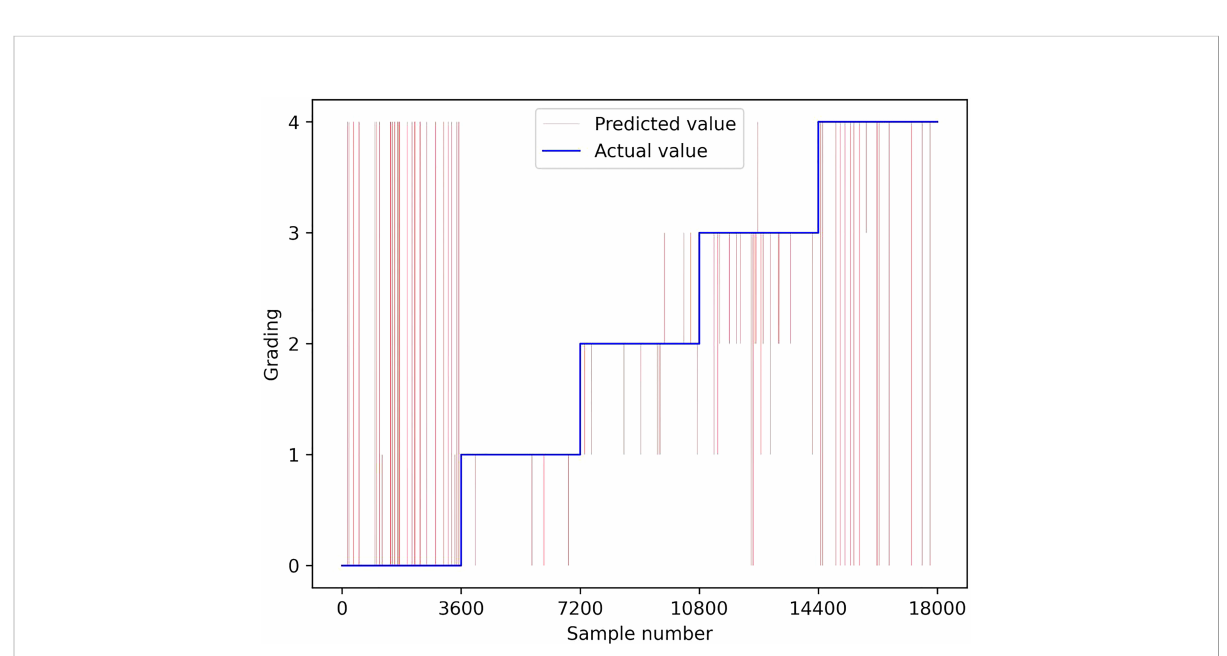
FIGURE 7 Grading Results of DSHT Model. The blue line is the ture value and the red line is the grading results predicted by